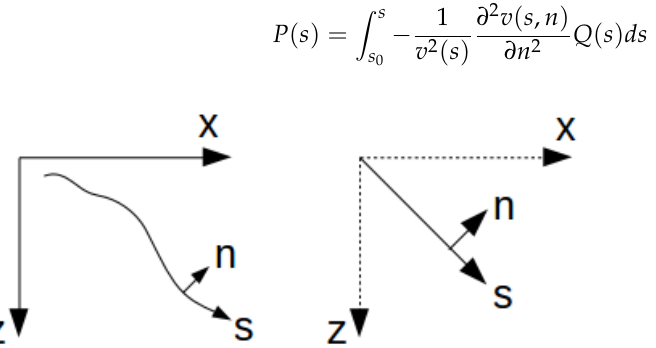
Figure 3. Ray-center coordinates and ray-direction